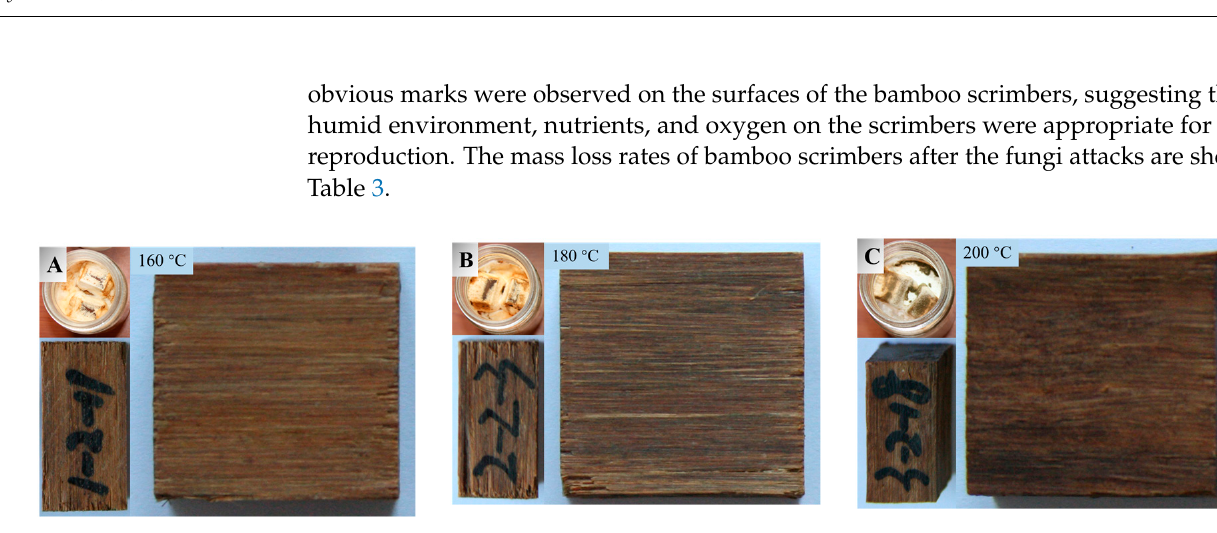
Figure 9. Surfaces of (a) 160, (b) 180 and (c) 200 °C -treated bamboo scrimbers attacked by white-rot fungi.